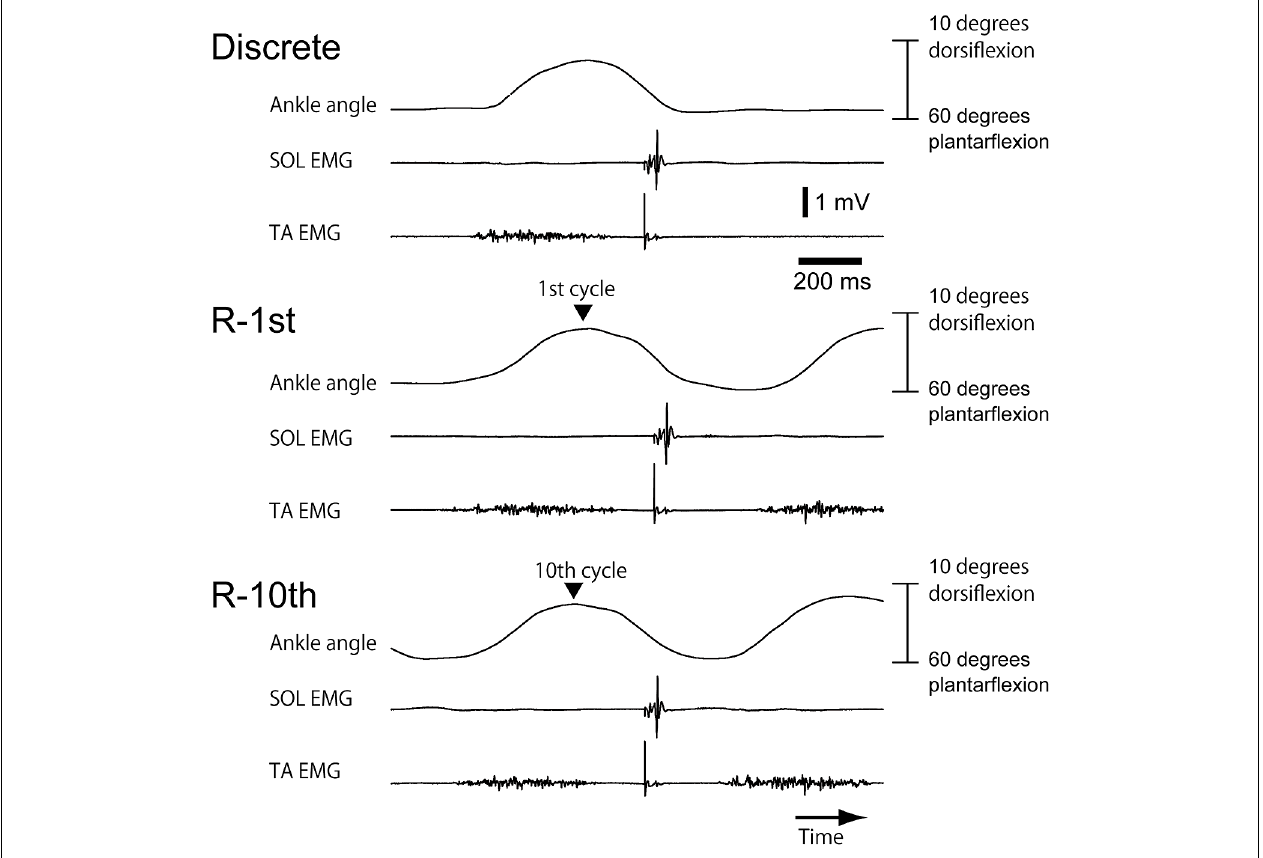
FIGURE 3 |An example of ankle movement and EMG traces from a subject in Section “Experiment 1.” The upper EMG trace indicates SOL-EMG and the lower EMG trace indicatesTA-EMG. A sharp negative peak on each EMG trace indicates the artifact of tibial nerve stimulation.